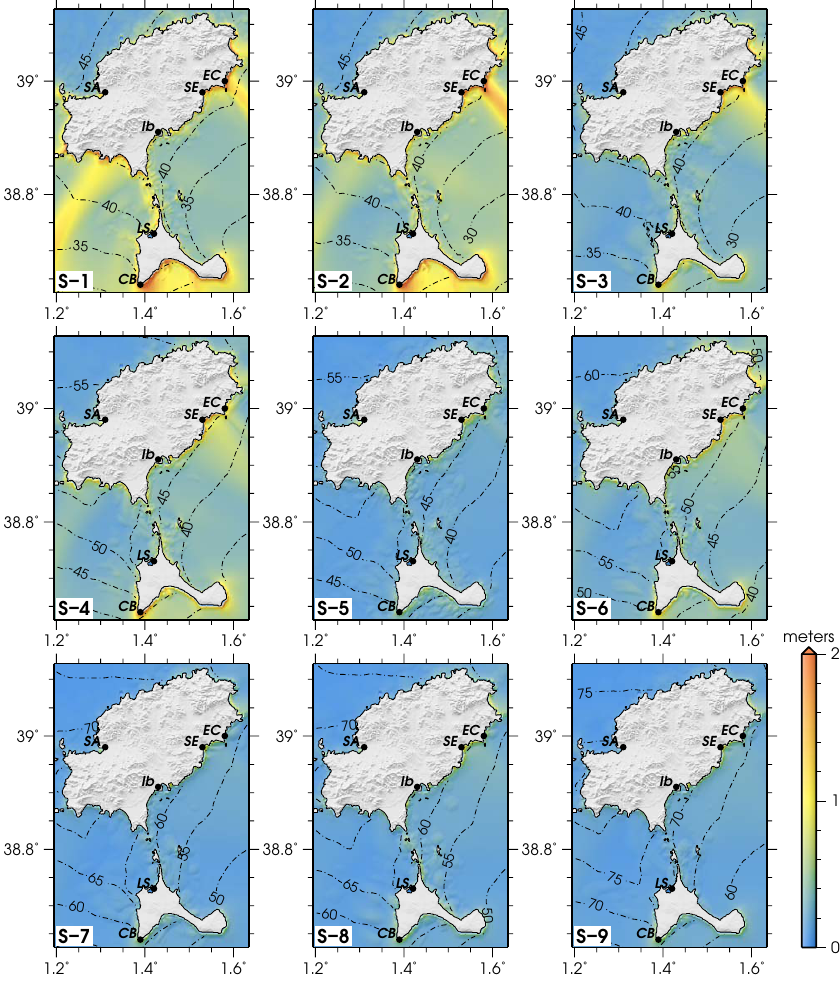
Fig. 6. Maximum wave elevation maps and estimated tsunami travel times for the islands of Ibiza and Formentera. The shading represents the wave elevation value as shown in the colour scale at the right. The contours show the tsunami travel time in 5min steps from the source. Black dots show the location of relevant populations: Ib, Ibiza; SE, Santa Eul`aria des Riu; EC, Es Canar; SA, Sant Antoni de Portmany; LS, La Savina; CB, Cap de